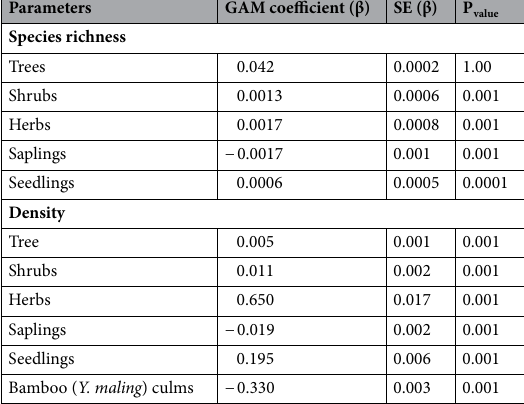
Mean ± SE Bamboo plots (Bamboo density = 300.08 ± 32.69; n = 51)